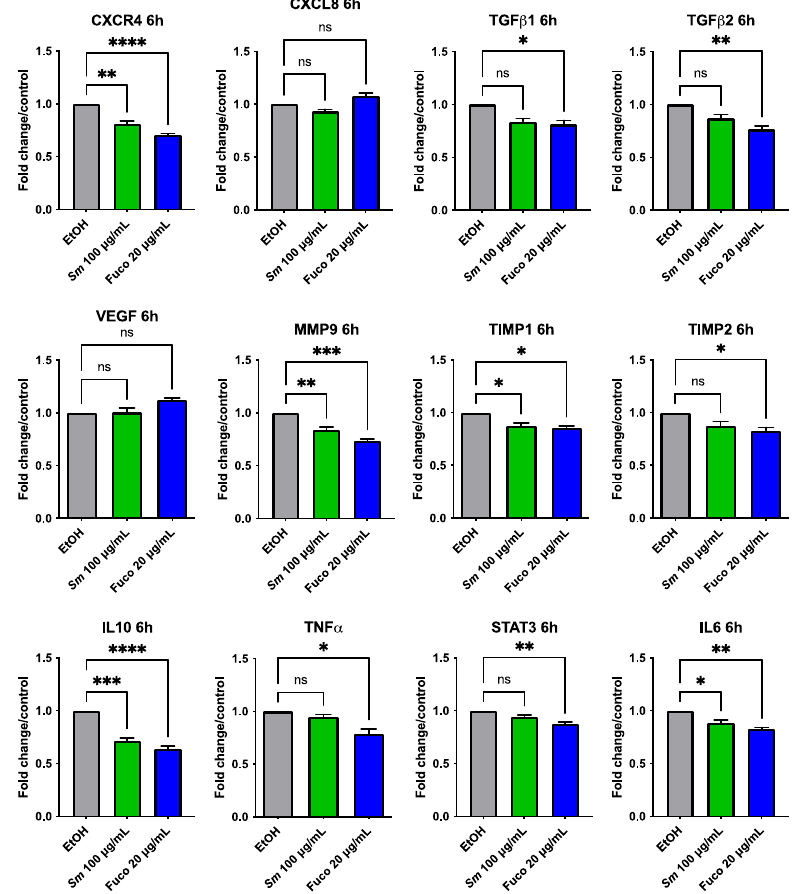
Figure 6. Gene expression profiling in PCa cell treated with S. marinoi and fucoxanthin. The ability of Sm (100 µg/mL) and Fuco (20 µg/mL) to inhibit gene expression in DU145 cells was determined by qPCR following 6 h of treatment. Data are shown as relative mRNA expression normalized to β -actin, results are shown as mean ± SEM, one-way ANOVA, ns = not significant, * = p < 0.05, ** = p < 0.01, *** = p < 0.001, **** = p < 0.0001. ( n =